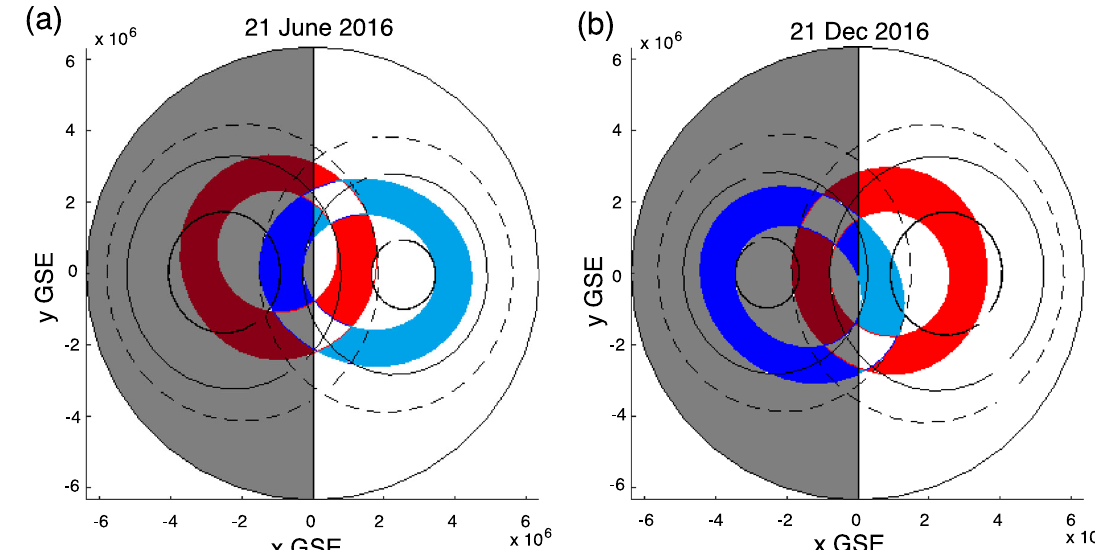
Fig. 3 Asymmetric interhemispheric auroral zone solar illumination. The fi gure shows the two-dimensional projection in GSE x – y coordinates of the traces of the north (blue) and south (red) auroral ovals, each assumed here to lie between lines of constant altitude adjusted corrected geomagnetic (AACGM) latitude from 65 – 75° during matching UT times for northern summer ( a ; 21 June 2016) and northern winter ( b ; 21 December 2016) solstices. The solid and dashed black lines denote the loci of the edges of the ovals in the northern and southern hemispheres as a result of diurnal rotation during the northern summer ( a ) and winter ( b ) solstices. The bold solid black circle at high latitudes denotes the locus of the geomagnetic poles. The solid vertical line denotes GSE x = 0 mark/the terminator. The area in Earth ’ s shadow is shown in